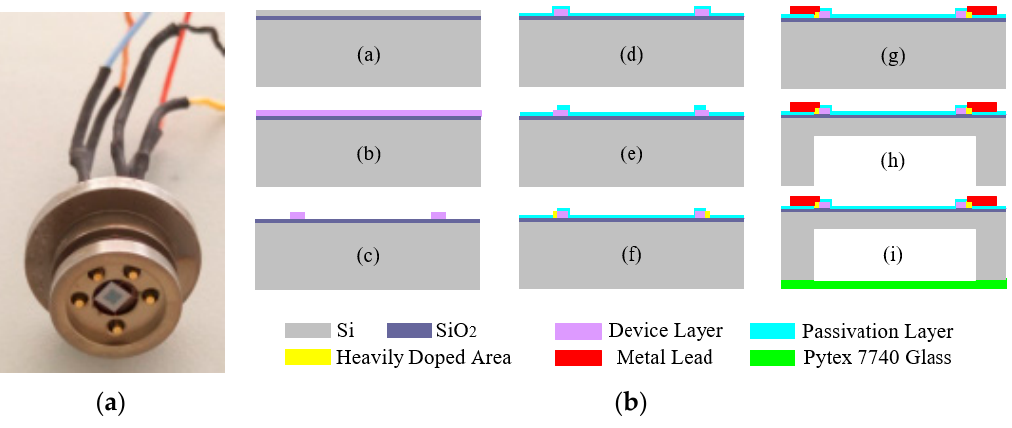
Figure 6. The developed high-temperature pressure sensor and fabrication process: ( a ) the high-temperature pressure sensor; ( b ) the MEMS fabrication